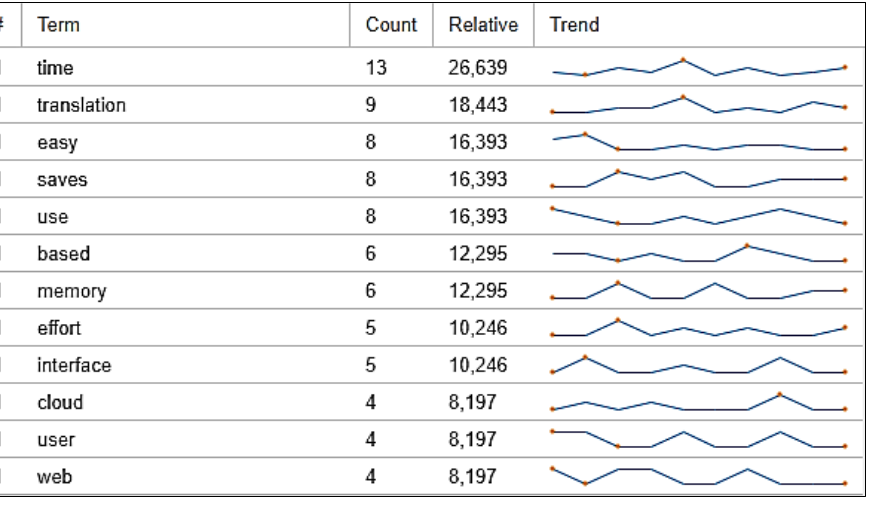
Figure 3. Most frequent words in participants’ responses on the best feature of CAT.